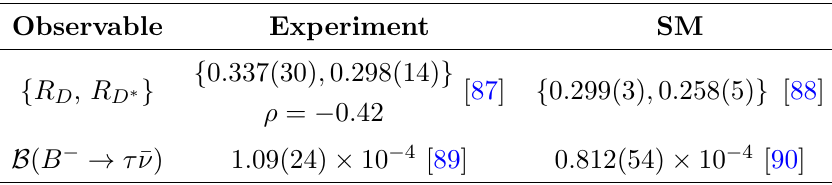
Table 2 . Experimental results and SM predictions for b → c ( u ) τ ¯ ν decays. In the first entry, we provide the present combined experimental average, with ρ denoting the correlation among the two